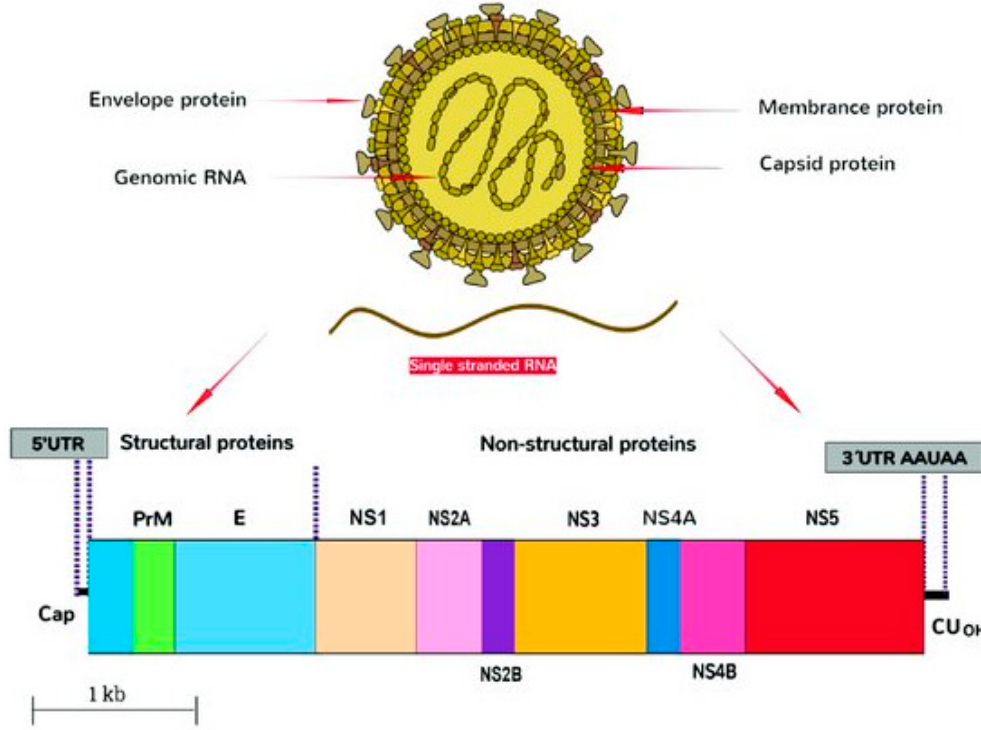
Figure 1. The three structural proteins and seven non-structural (NS) proteins of Flaviviruses. Reproduced under the Creative Commons Attribution License from [12].